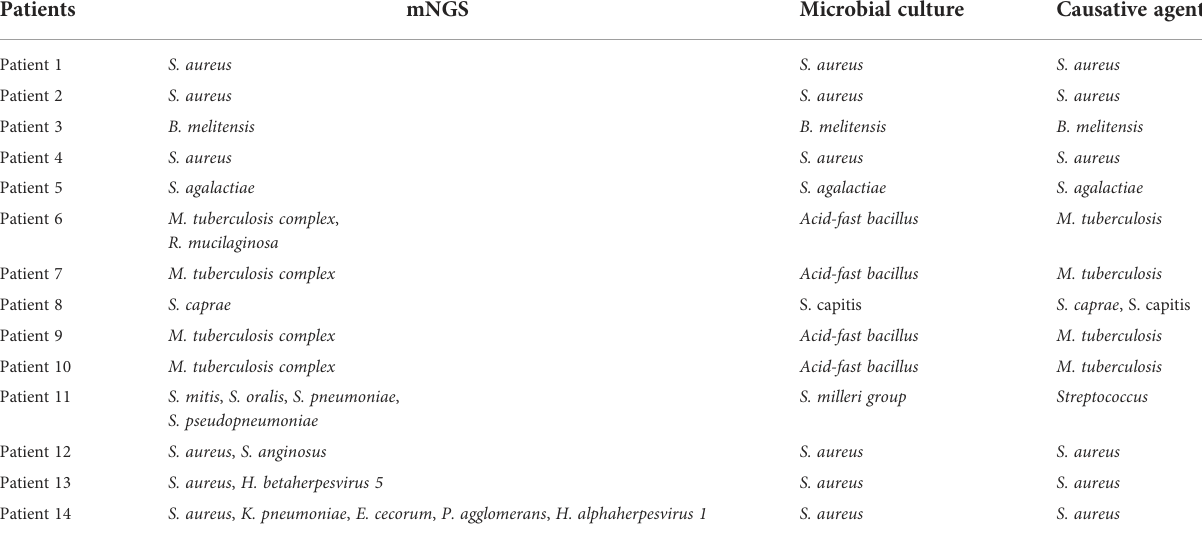
TABLE 4 Matching of pathogenic microorganisms detected by mNGS and microbial culture.